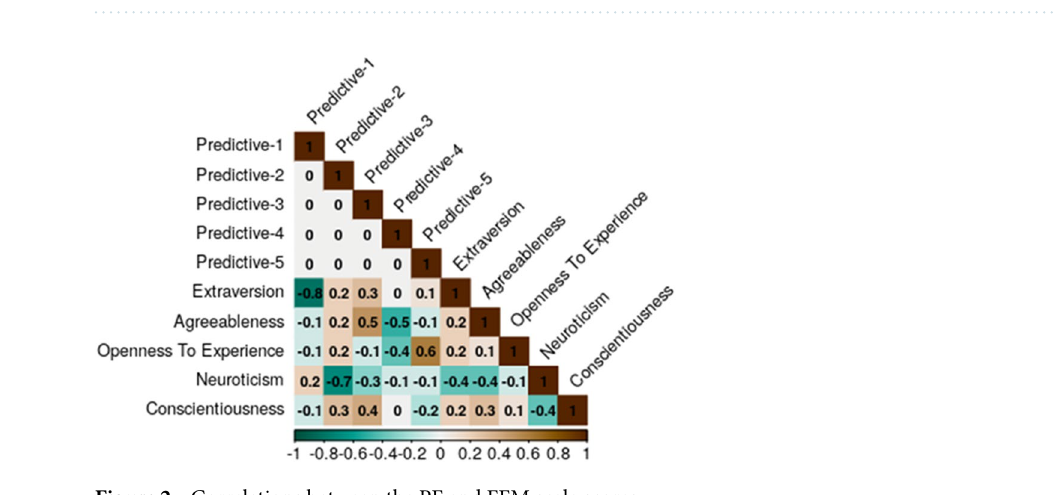
Figure 1. Correlations between the 10 outcome variables, 5 principle components of outcome variables, and the 5 PF dimensions.